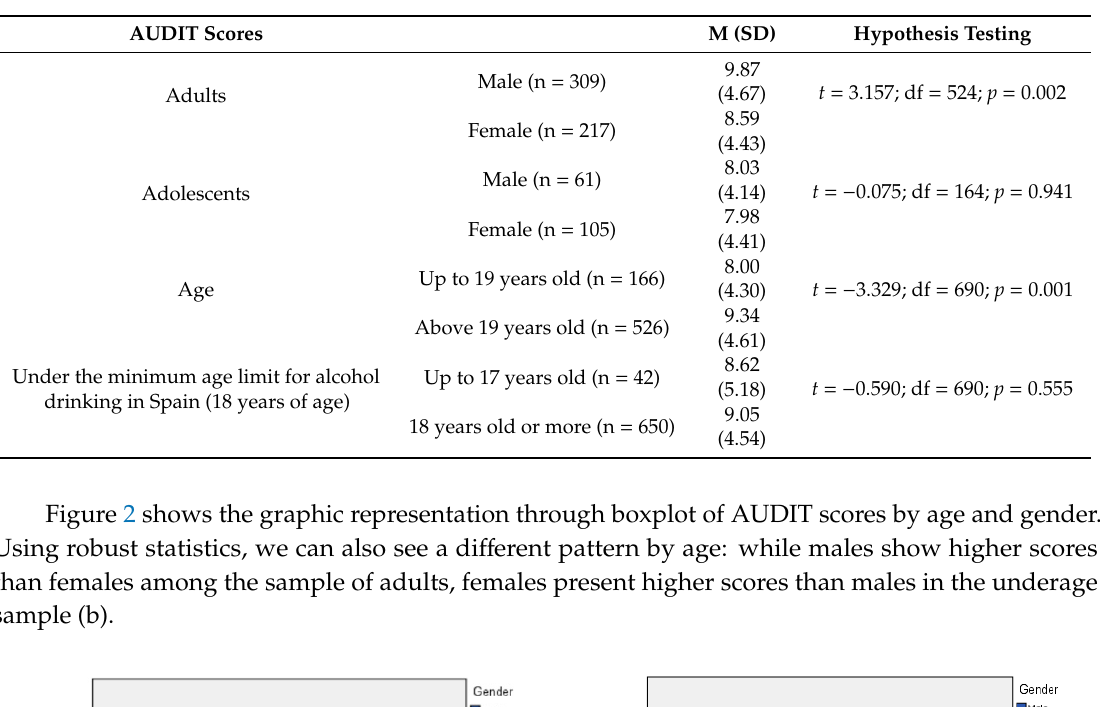
Table 6. Pearson correlation between BrAC scores and perception of drunkenness (in participants with BrAC > 0 and controlling by minutes in drinking environment) and proportion of participants who indicated the different answers in perception of drunkenness.